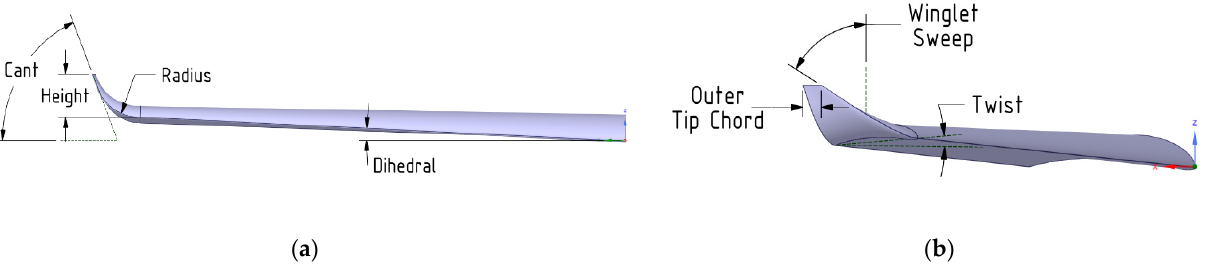
Figure 1. ( a ) Front view of the designed wing with the winglet ( b ) Perspective view of the designed wing with the winglet.